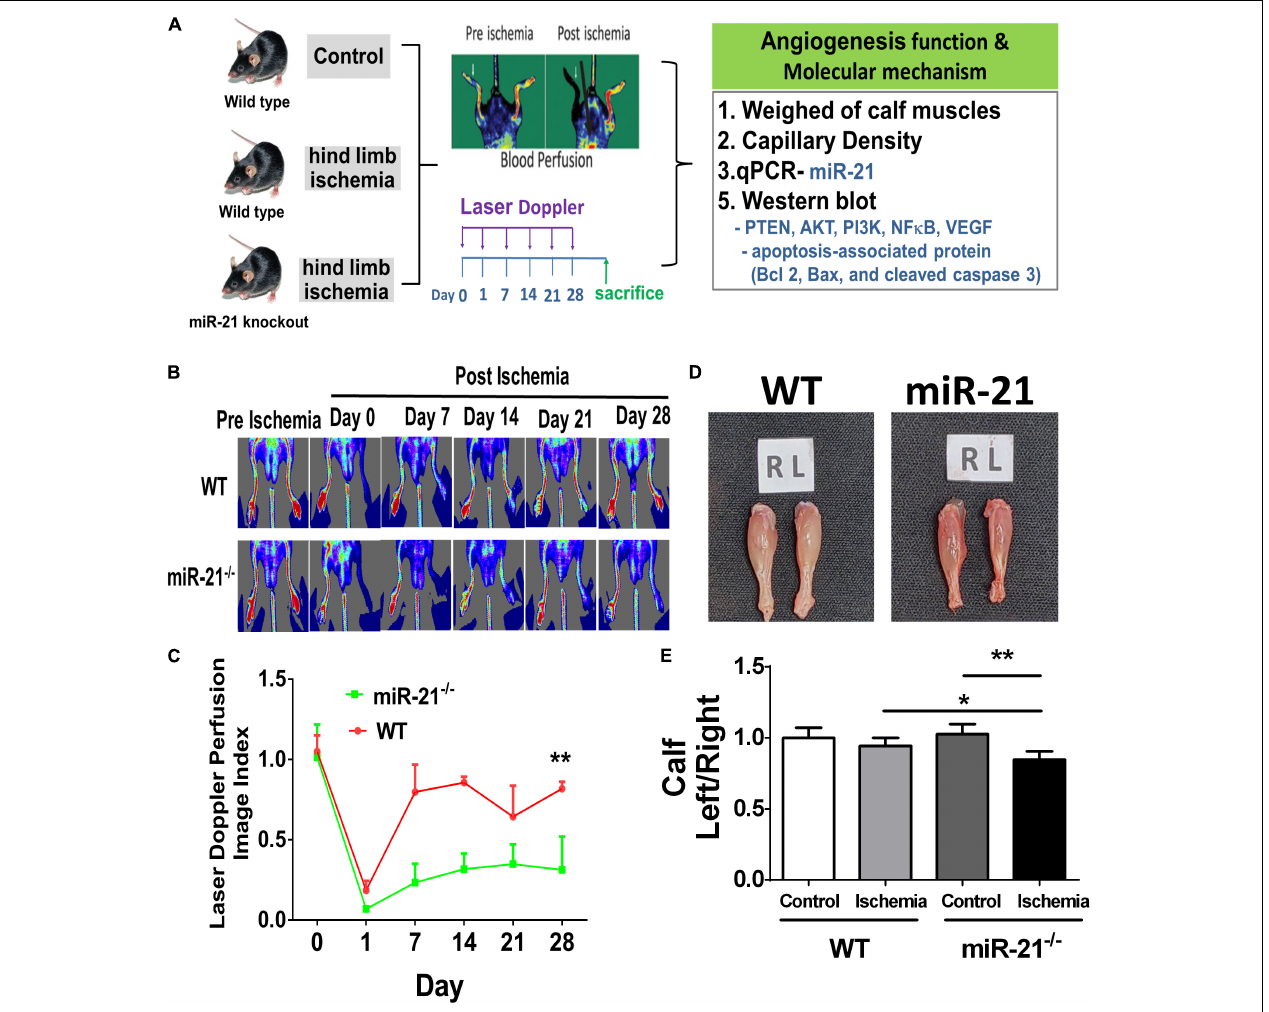
FIGURE 1 | Impaired angiogenesis of wild-type and microRNA-21 (miR-21) – / – mice post hindlimb ischemia surgery. (A) The study design of limb ischemia in wild-type and microRNA-21 (miR-21) – / – mice. (B) Representative images of laser Doppler perfusion flow in limb ischemia in mice. (C) Quantification of LDPI at 0, 7, 14, 21, and 28 days after surgery and recovery of perfusion as expressed by the blood flow ratio (ischemic leg/non-ischemic leg) were measured. (D) Representative images and weight quantifications of harvested ischemic (left; L) limbs compared with non-ischemic (right; R) limbs. (E) The graph quantifying calf muscle weight loss in WT and miR-21 – / – . N = 6, * P < 0.05, ** P <